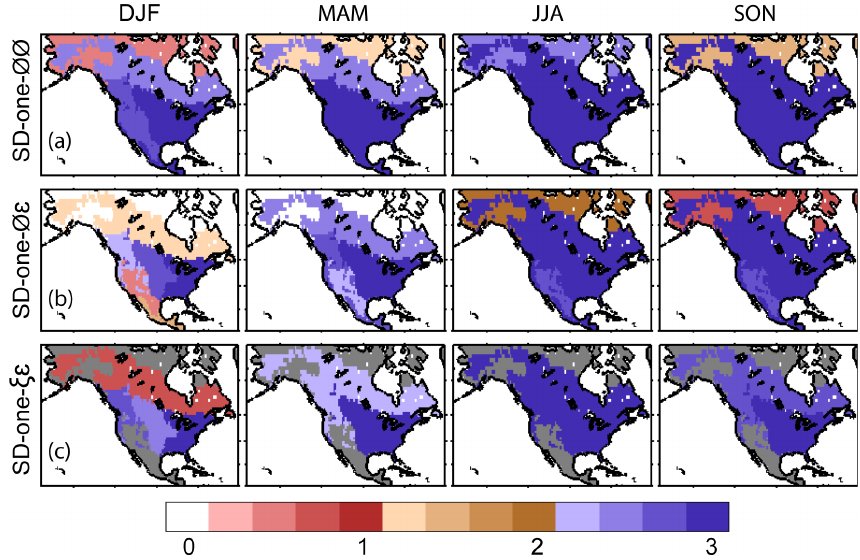
Figure 4. Average numbers of months within each season for which the candidate TBM is selected for the SD-one- ∅∅ , SD-one- ∅ ε and SD-one- ξε case studies (Fig. 3). Grey shading in SD-one- ξε represents biomes that were determined to be not sufficiently well constrained by available atmospheric data. DJF: December, January, February; MAM: March, April, May; JJA: June, July, August; SON: September, October, November. The criteria for grey areas include (1) no models being selected in one season, or (2) the overall model selection being less than 50% in a